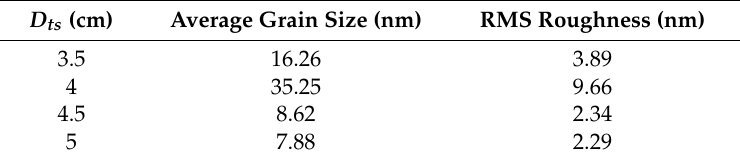
Figure 6. Three-dimensional surface morphologies of CdTe films deposited at different substrate-target distances, D ts . ( a ) 3.5 cm; ( b ) 4 cm; ( c ) 4.5 cm; and ( d ) 5 cm. Table 3. Surface morphology parameters of CdTe films prepared at different substrate-target distances. D ts (cm)